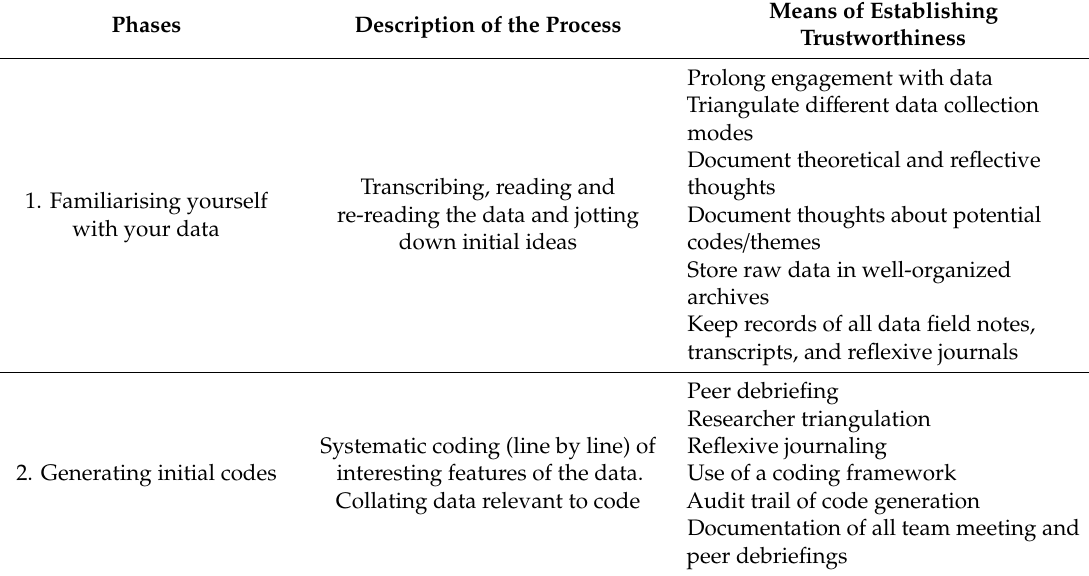
Table 4. Thematic analysis [26] and establishment of trustworthiness